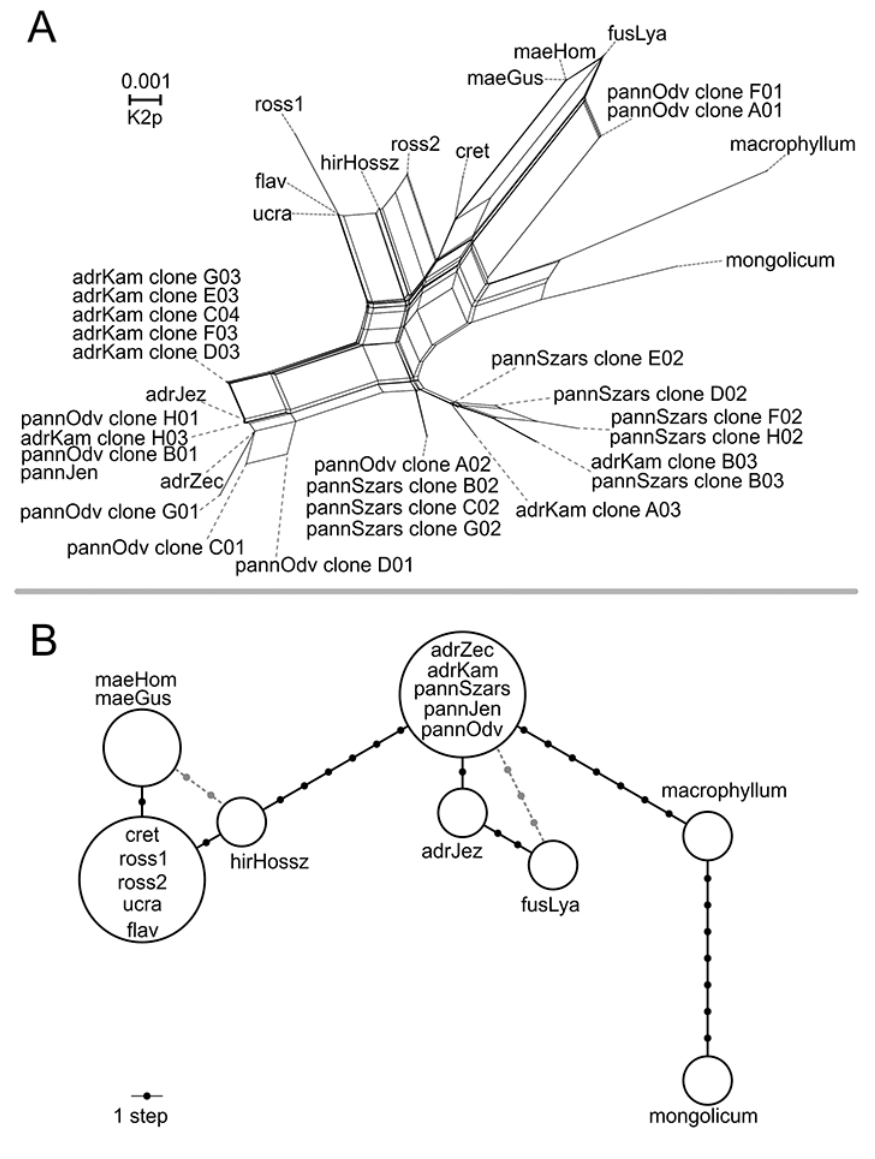
Figure 2 NeighborNet of nrITS ribotypes reconstructed in SplitStree based on K2p distances ( A ) and haplotype network of trn H- psb A haplotypes reconstructed using PEGAS ( B ). Small unlabeled dots in ( B ) represent hypothetical haplotypes that were not sampled. Identification codes used here refer to Table